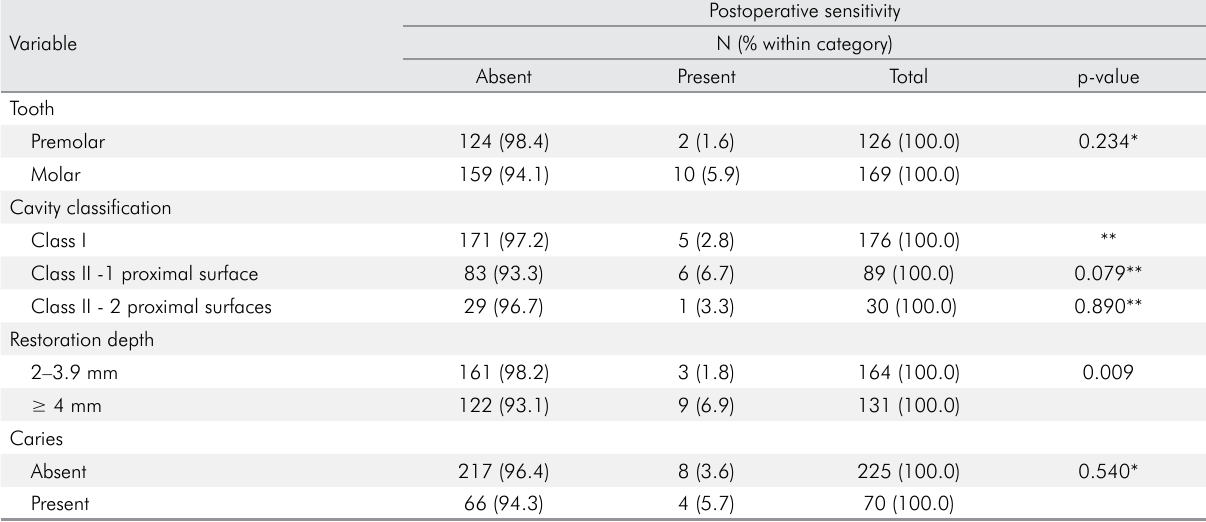
Table 5. Comparison of the number of restorations (%) that experienced spontaneous postoperative sensitivity during the one-week follow-up according to the characteristics of dental arches and